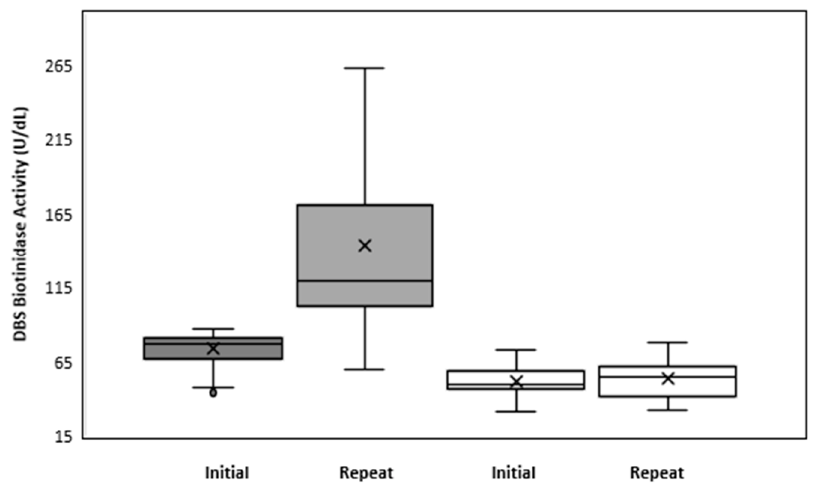
Figure 2. DBS biotinidase activity in false positives (gray boxes) and true positives (white boxes) at the initial and repeat DBS screening test.